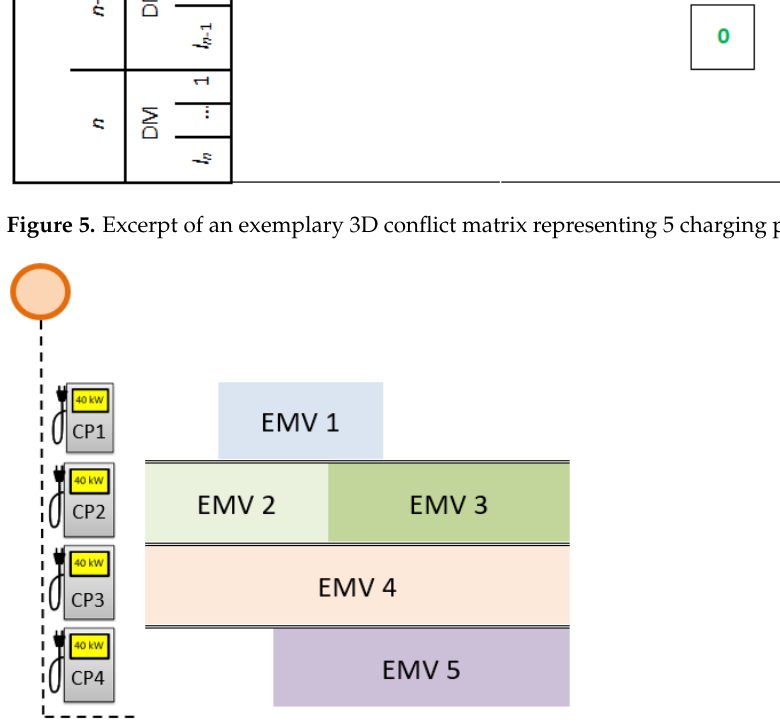
Figure 6. Gantt chart for “the charger as a charging point”